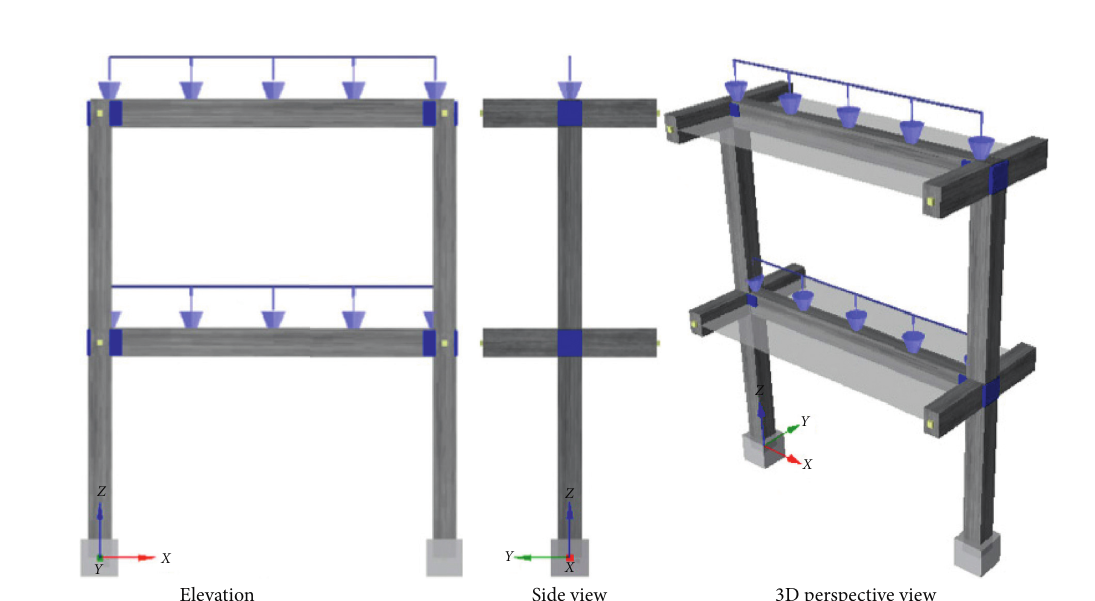
Figure 13: Representative nonlinear model developed in curves for the ten selected accelerograms have been shown in Figure 15.